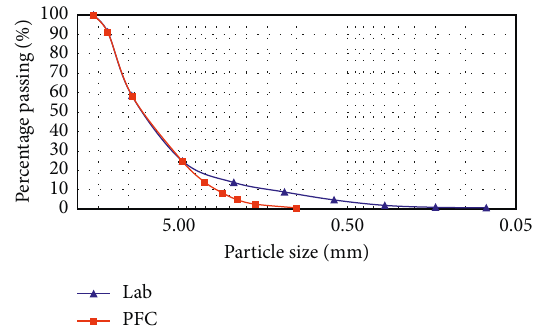
Figure 1: Gradation curves of the prototype and